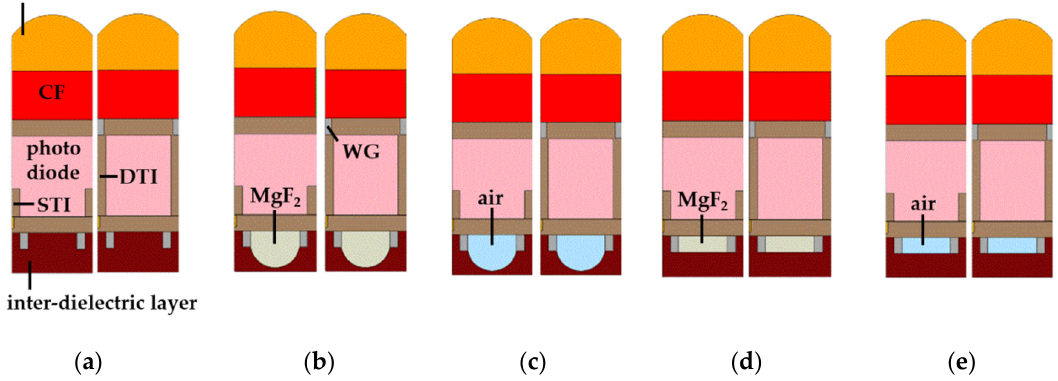
Figure 3. Cross-section of the simulated pixel structures in the 1.0 µ m pixel depth. The left pixel of all cross-sections had STI, and the right pixel had DTI and WG: ( a ) Typical structure, ( b ) front-inner lens with MgF 2 , ( c ) front-inner lens with air, ( d ) square front-inner lens with MgF 2 , and ( e ) square front-inner lens with air.